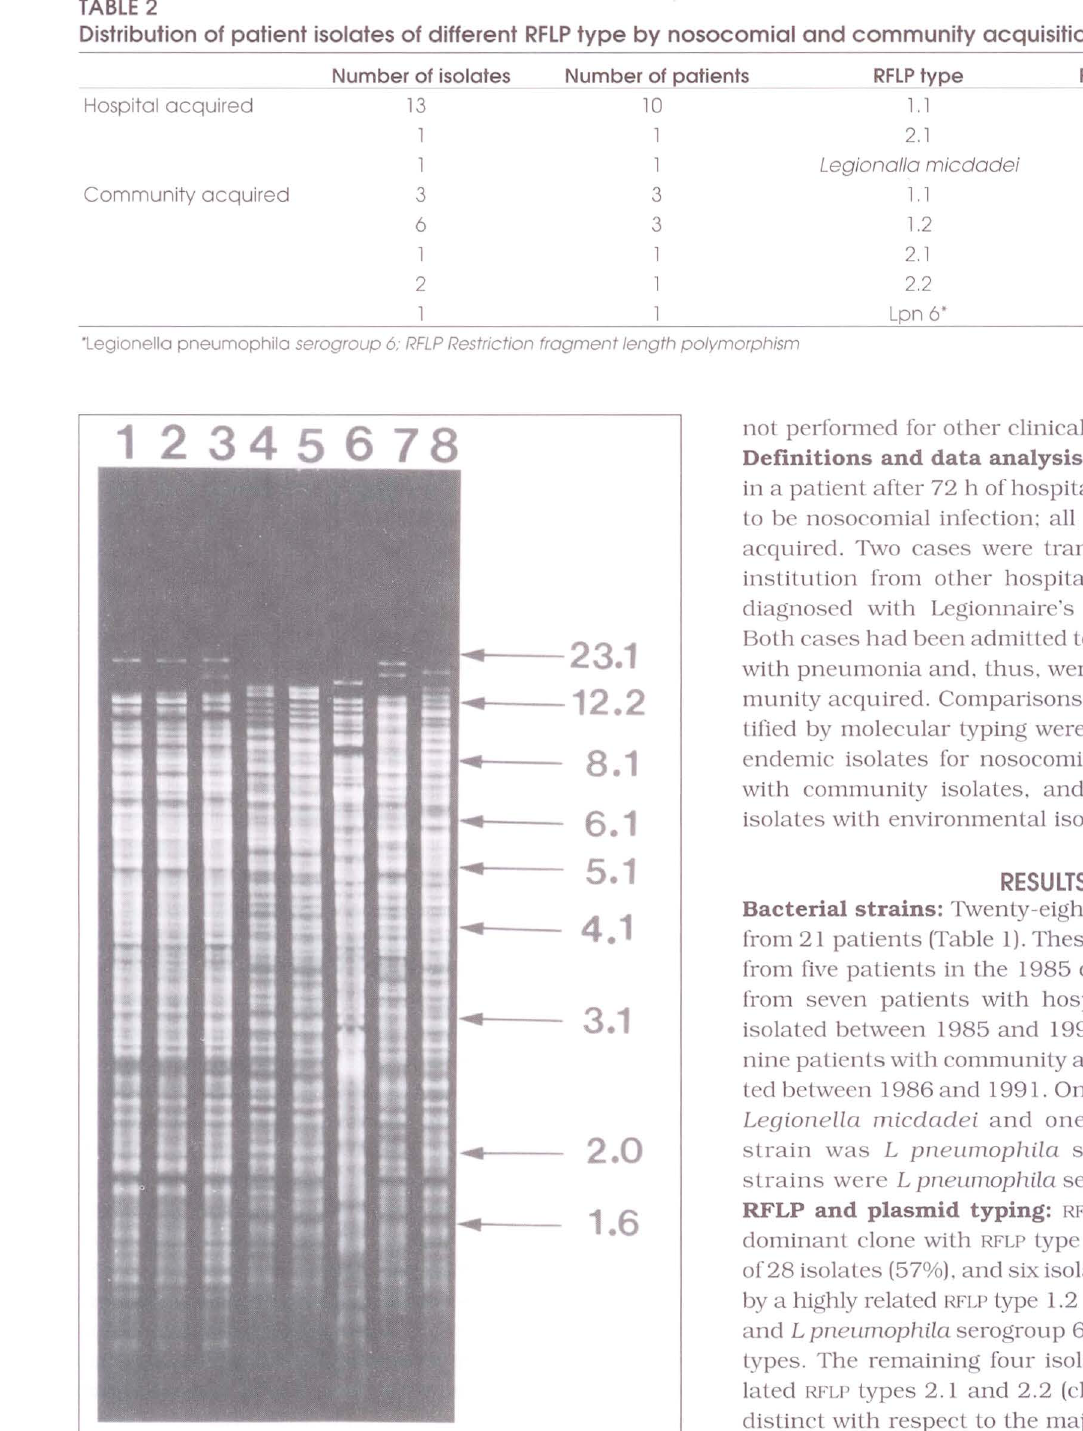
Figure 1) Agarose gel electrophoresis of Hindi/ digested total DNA}i"om nosocomial (N). community (C) and enuironmental